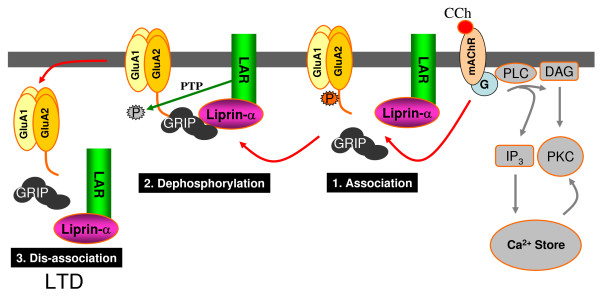
A novel mechanism of LTD involving liprin-α and LAR. Activation of mAChRs leads to a G-protein dependent mAChR-LTD that does not involve the canonical pathway (IP3 and PKC). The data can most simply be explained by GRIP acting as a targeting molecule that brings LAR and the GluA2 subunit of AMPARs into contact. This then enables LAR to dephosphorlyate a tyrosine residue (such as YGIESVKI on GluA2) which initiates the removal of the AMPAR from the synapse.